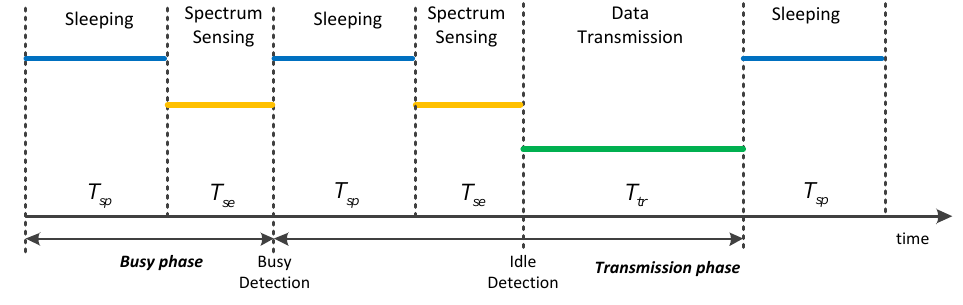
Figure 6. The part of slotframe structure.